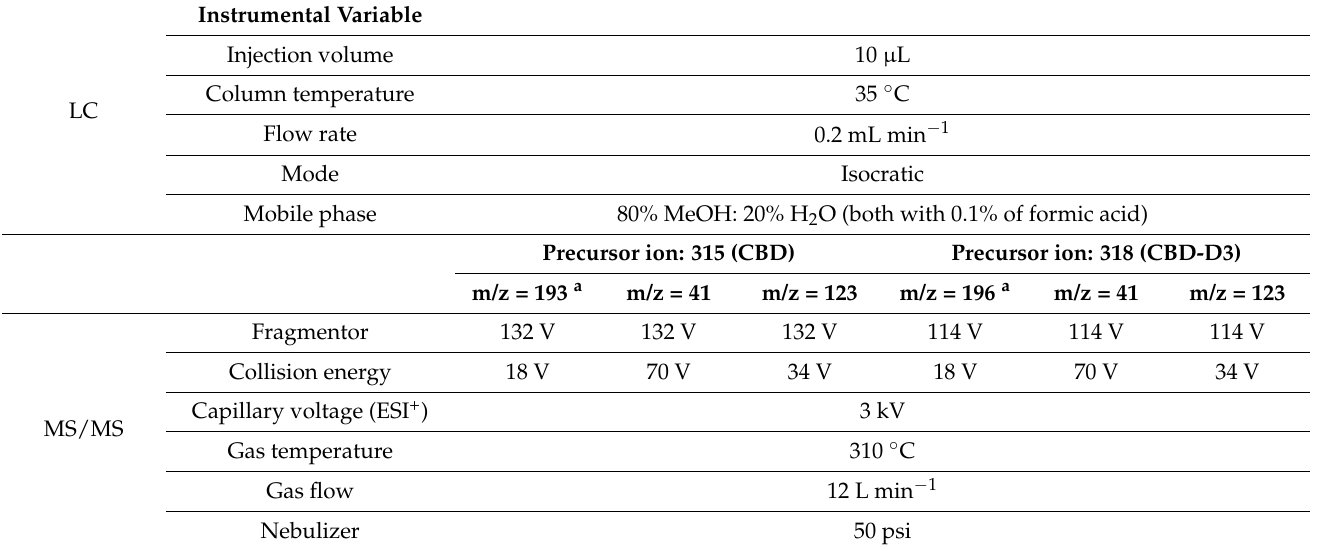
Table 1. Instrumental variables of LC-MS/MS